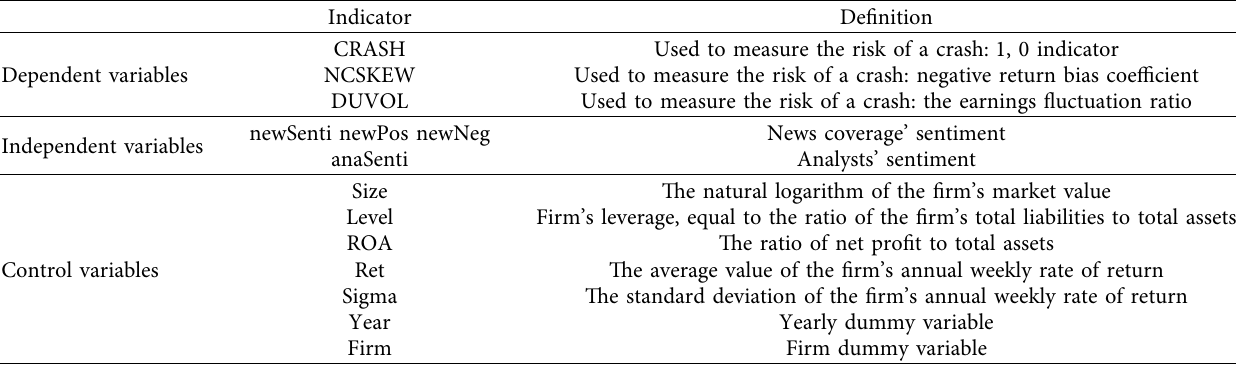
Table 3: Variables and